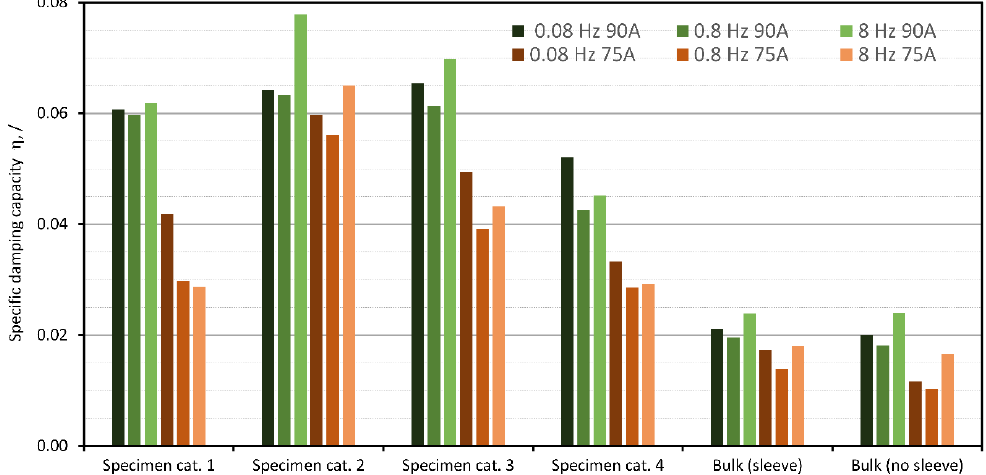
Figure 13. Damping performance in terms of energy dissipation presented by specific damping capacity parameter 𝜂 . Figure 13 confirms that the test specimens with specific initial prestress perform bet- ter compared to the other four categories of test specimens, especially at 8 Hz. However,